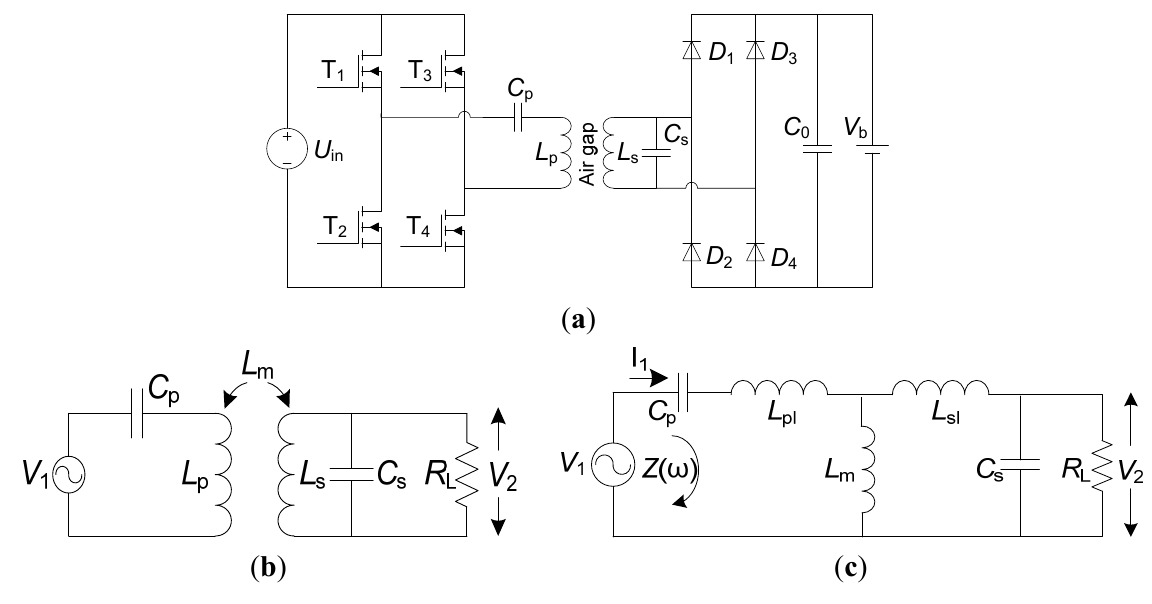
Figure 3. Circuit diagram of proposed WPT system: ( a ) SP topology for WPT; ( b ) Simplified SP topology; ( c ) Equivalent circuit of SP